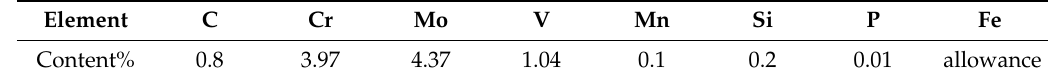
Table 1. Chemical composition of M50 material (mass